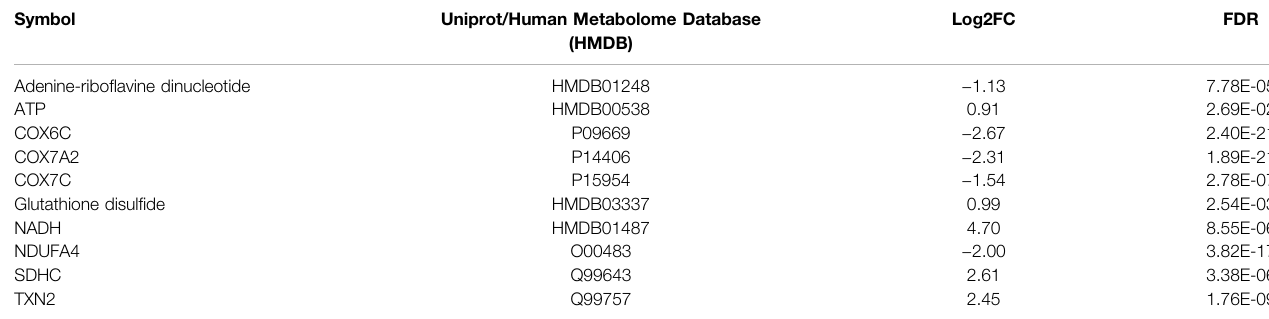
TABLE 4 | List of the proteins and metabolites found altered in the mitochondrial dysfunction pathway in MitoPPX cells compared to Wt (meta-analysis conducted by IPA software). Table shows increase (log 2 FC > 0) or decrease (log 2 FC < 0) of different proteins and metabolites involved in the canonical pathway of mitochondrial dysfunction in the meta-analysis. FDR: False Discovery